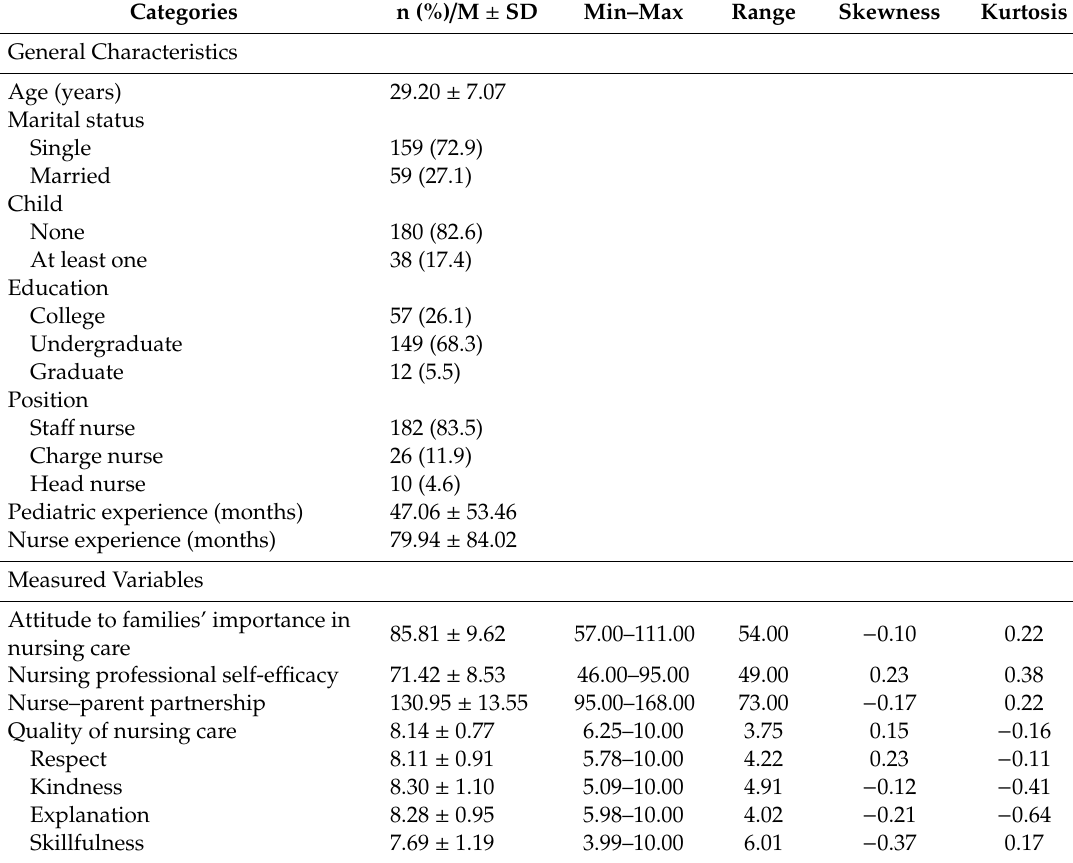
Table 1. General characteristics of pediatric nurses and descriptive statistics of the measured variables ( N =